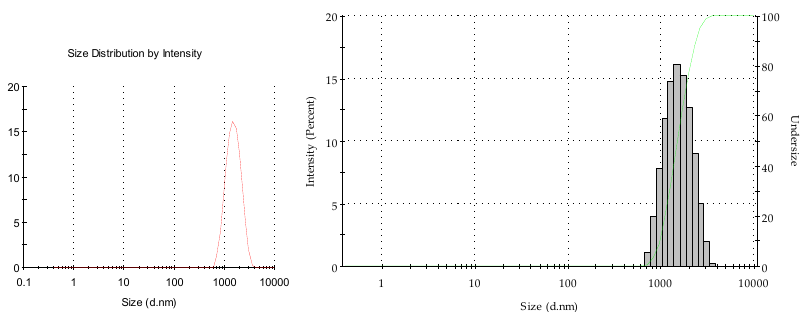
Figure 2. Dynamic light scattering (DLS) measurements for hydrodynamic diameters of colloidal copper particles.